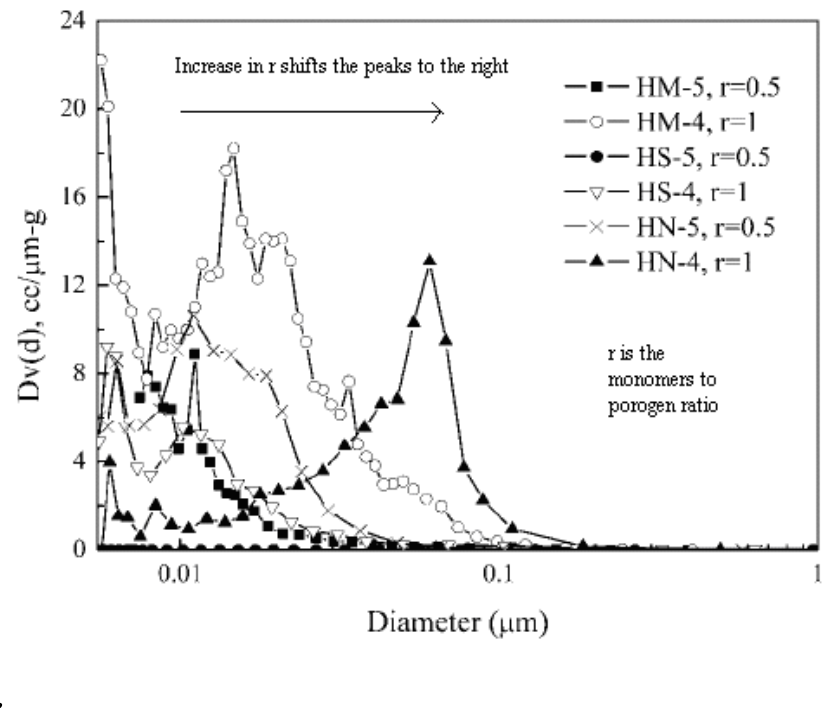
Figure 4. Pore size distribution of porous HM-poly(2-hydroxyethyl methacrylate- co - methyl methacrylate), HS - poly(2-hydroxyethyl methacrylate- co -styrene), and HN-poly(2- hydroxyethyl methacrylate- co - N -vinyl-2-pyrrolidone) particles. r is the ratio of monomer to porogen. PSD shifts to the right side when r increases. (Reprinted (adapted) with permission from [46]. Copyright 2008 American Chemical